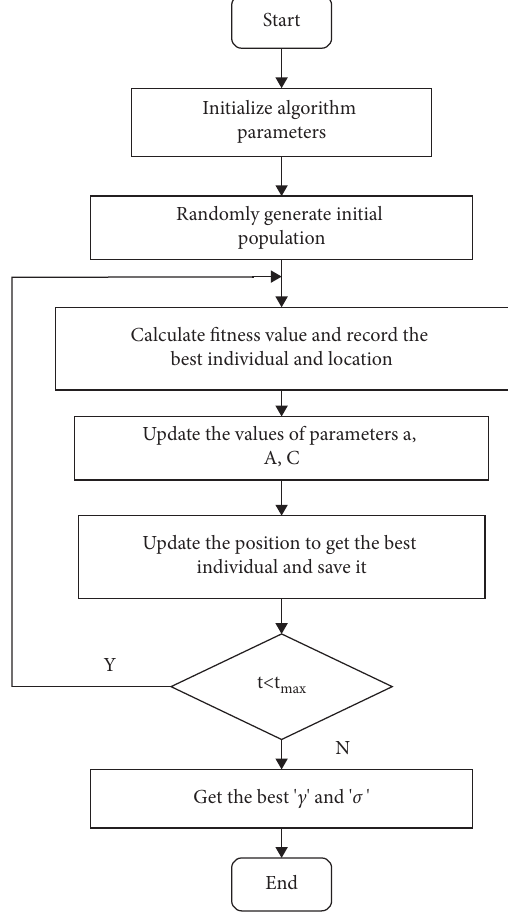
Figure 3: IWOA-LSSVM flowchart.